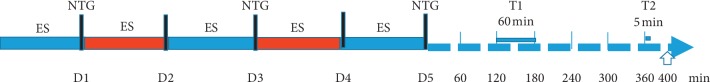
Experimental procedure. ES: auricular electrical stimulation (ES) pretreatment; NTG: nitroglycerin (10 mg/kg) intraperitoneal (i.p.) injection; D1: first day; D2: second day; D3: third day; D4: fourth day; D5: fifth day; T1, 60 min: rat behavior recognition module video recordings for 60 min; T2, 5 min: open-field test recordings for 5 min; the rats were euthanized 400 min after i.p. NTG injection on the fifth day (arrow head).